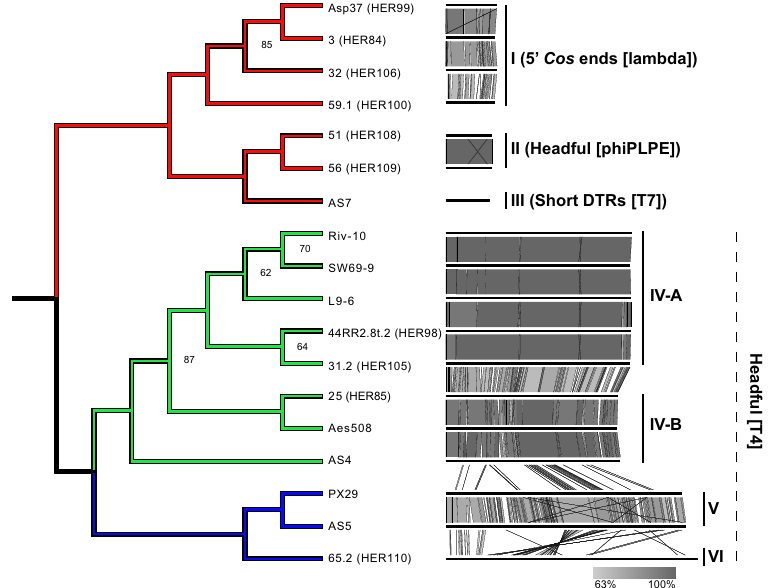
Figure 2. Clustering based on the gene repertoire. Phages having a small, medium and large size genome are in red, green and blue, respectively. The AU (Approximately Unbiased) p -value is indicated at each node when inferior to 100. Alignment of genomes and the proposed grouping are coupled to the tree. The inferred mode of DNA packaging is indicated for each